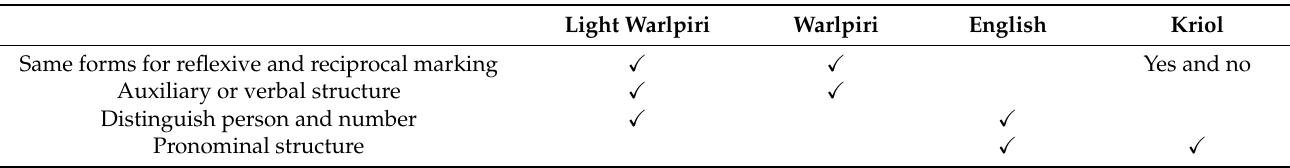
Table 6. Comparison of reflexive and reciprocal structures in Light Warlpiri and its source languages, Warlpiri, English and Kriol.